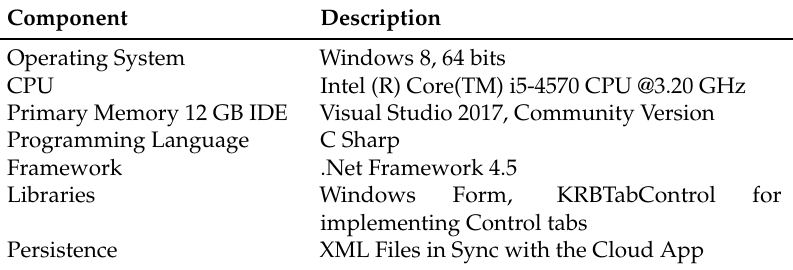
Table 3. Technology stack of the DIY